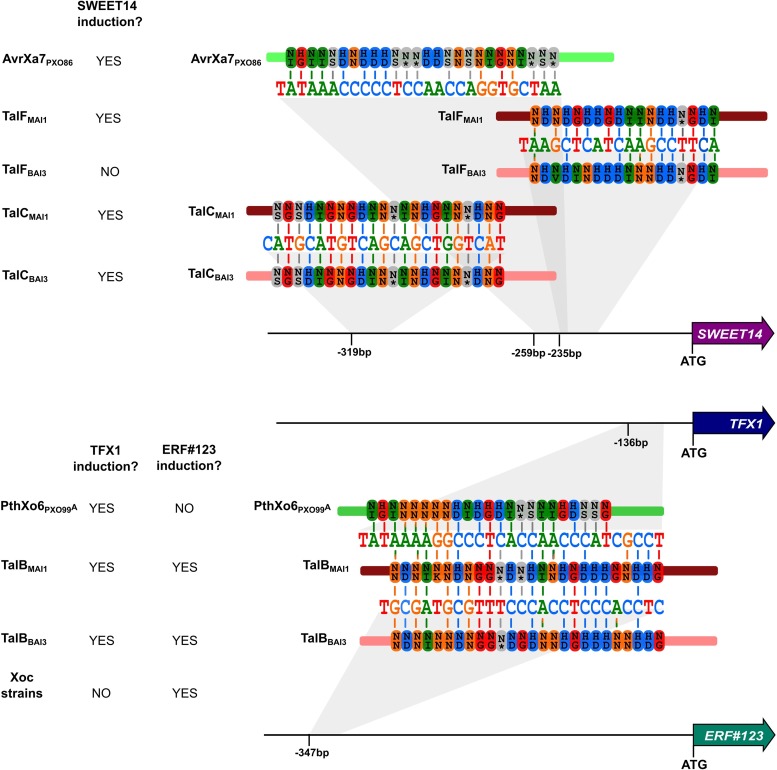
Functional convergence and dual targeting activity among African X. oryzae pv. oryzae TAL effectors.Targeting of three susceptibility genes by multiple TAL effectors is shown. Not included in the figure, OsERF#123 is also induced by Tal3c from Xoc strain BLS256 upon binding to two EBEs, different from the one bound by TalB [61]. Genes are indicated as arrows, black horizontal lines correspond to the promoter region of the gene, and the distance of the targeted EBEs to the annotated translation start site is shown. EBE sequences are shown color-coded by nucleotide, and RVD sequences of TAL effectors are shown color-coded according to their nucleotide specificity. A vertical line between a nucleotide and an RVD highlights a match. To the left is indicated by YES instances where there is evidence that the corresponding gene is induced by the TAL effector, and by NO instances where there is no such evidence.